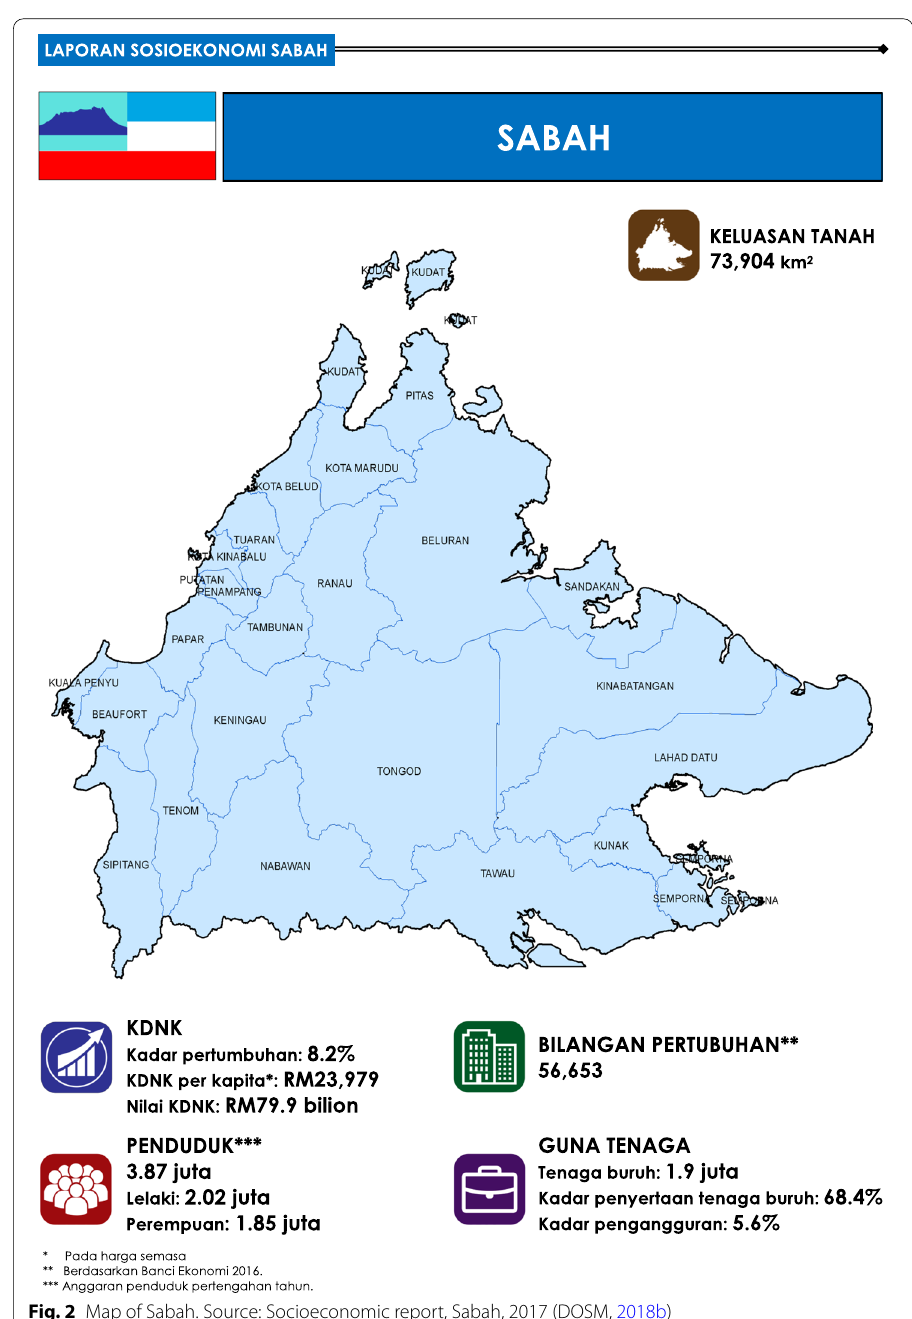
Fig. 2 Map of Sabah. Source: Socioeconomic report, Sabah, 2017 (DOSM,